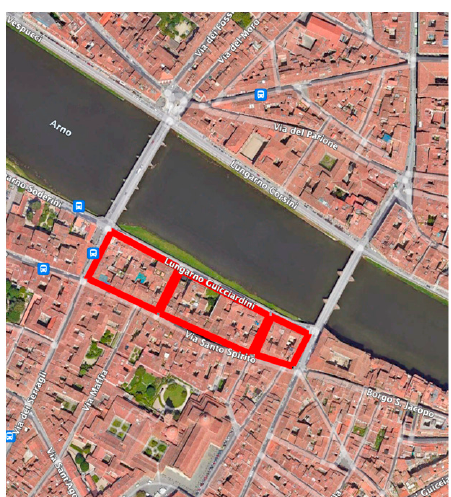
Figure 2. Laddarno area.